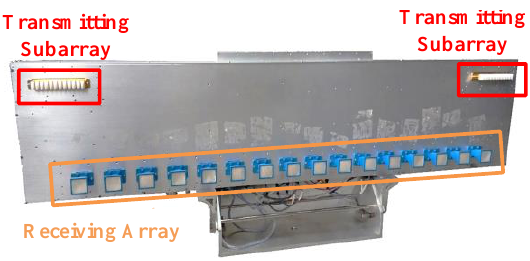
Figure 3. The MIMO system. Table 2. The MIMO system parameters.